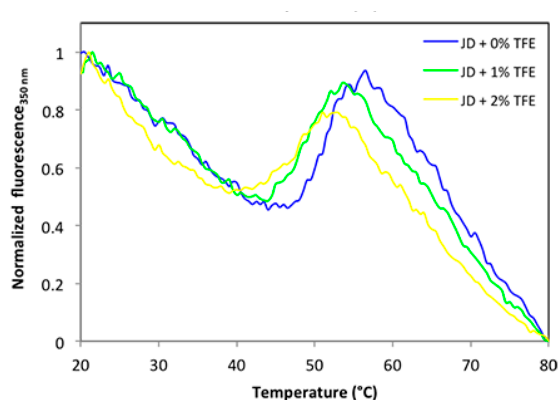
Figure 10. Chemical and thermal stability of JD in the presence of different TFE concentrations. ( A ) Equilibrium unfolding curves induced by GuHCl in the presence of 0%, 1% and 2% of TFE ( v / v ). Fluorescence emission were recorded at 25 °C and emission signal at 360 nm were plotted as function of denaturant concentration. ( B ) Thermal unfolding monitored by far-UV CD at 222 nm. Profiles were recorded at a rate of 1 °C/min in the presence of 0%, 1%, 2% and 5% of TFE ( v / v ). ( C ) Thermal unfolding monitored by fluorescence recording the tryptophan signal at 350 nm at a rate of 1 °C/min in the presence of 0%, 1%, 2% and 5% of TFE ( v / v ).